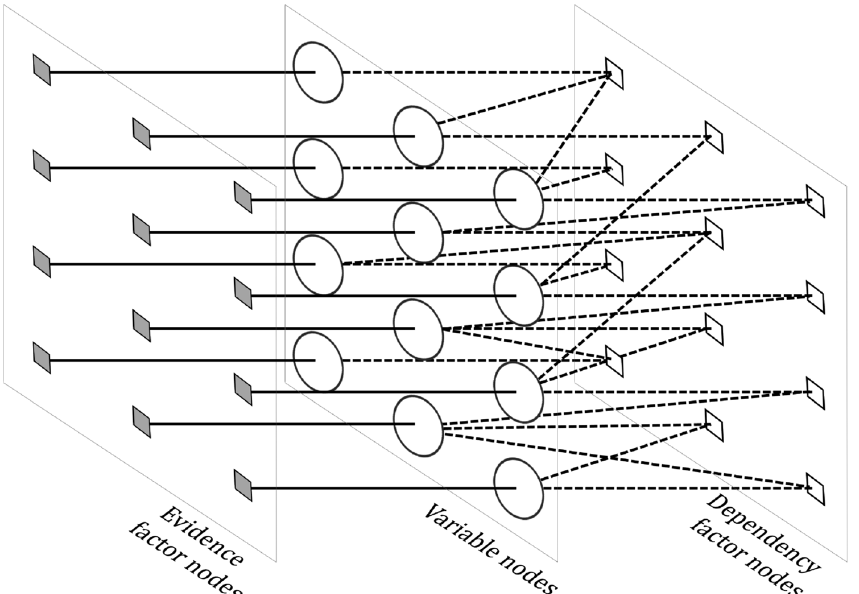
Figure 2. Schematic diagram of the proposed factor graph model (FGS algorithm) designed for optimal estimation of dense stereo disparities. For images of size M × N , there are MN number of variable nodes (circular nodes) V , MN number of dependency factor nodes (empty square nodes) S and MN number of evidence factor nodes (solid square nodes) E . The variable nodes represent posterior disparities to be estimated; the evidence factor nodes represent prior information about the dense disparities; and the dependency factor nodes represent the likelihood of satisfying spatial dependencies given localized disparity